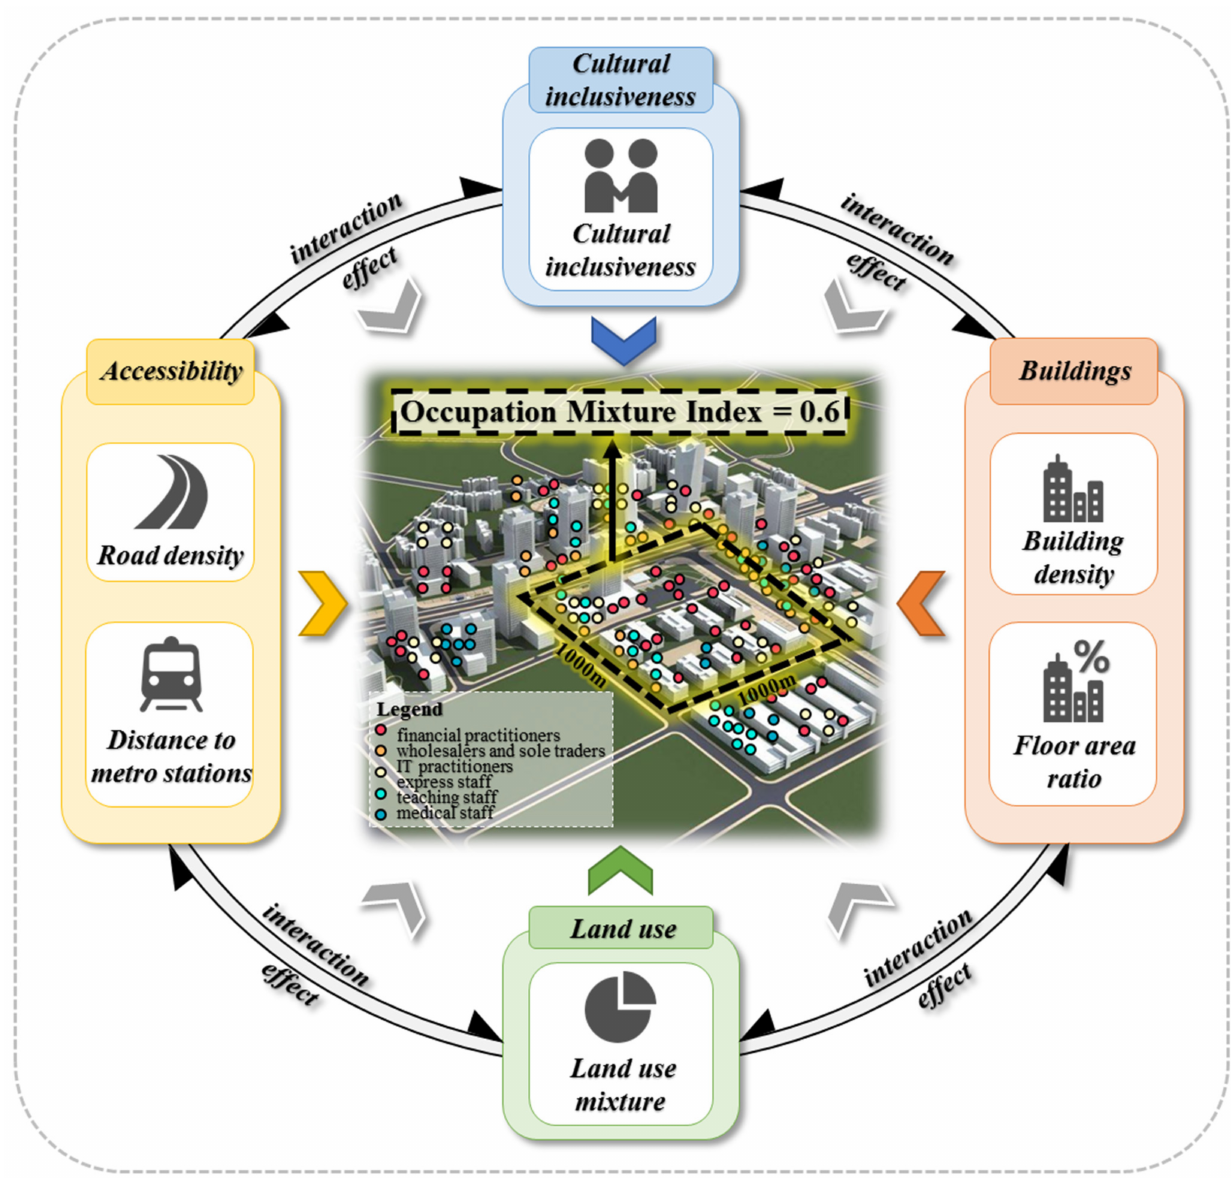
Figure 4. Factors influencing OMI